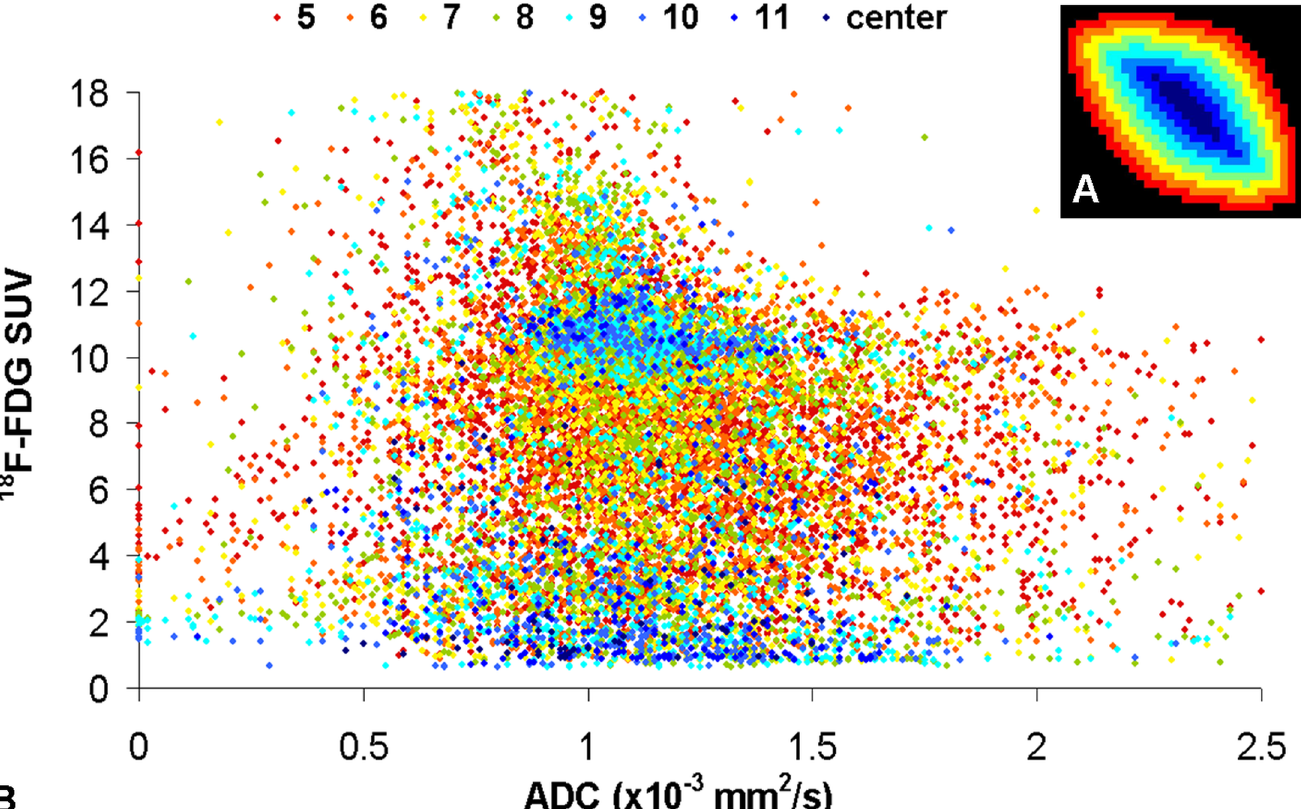
Fig 3. A-B. Scatter plot of the correlations of ADC and 18 F-FDG uptake (B). The colors from (A) denote the localization of the voxels (from red: periphery to blue: center). Voxels with high uptake of 18 F-FDG and lower ADC values can be found in all tumor parts (B). Surprisingly, there is a substantial number of voxels with low uptake of 18 F-FDG and lower ADC values, mainly located in the central areas, maybe due to high density of cells with low tumor activity or low density of tumor cells but dense tumor stroma caused by desmoplastic reactions (B). For higher ADC values > 1.5 x10-3 mm²/s the 18 F-FDG values are widely distributed